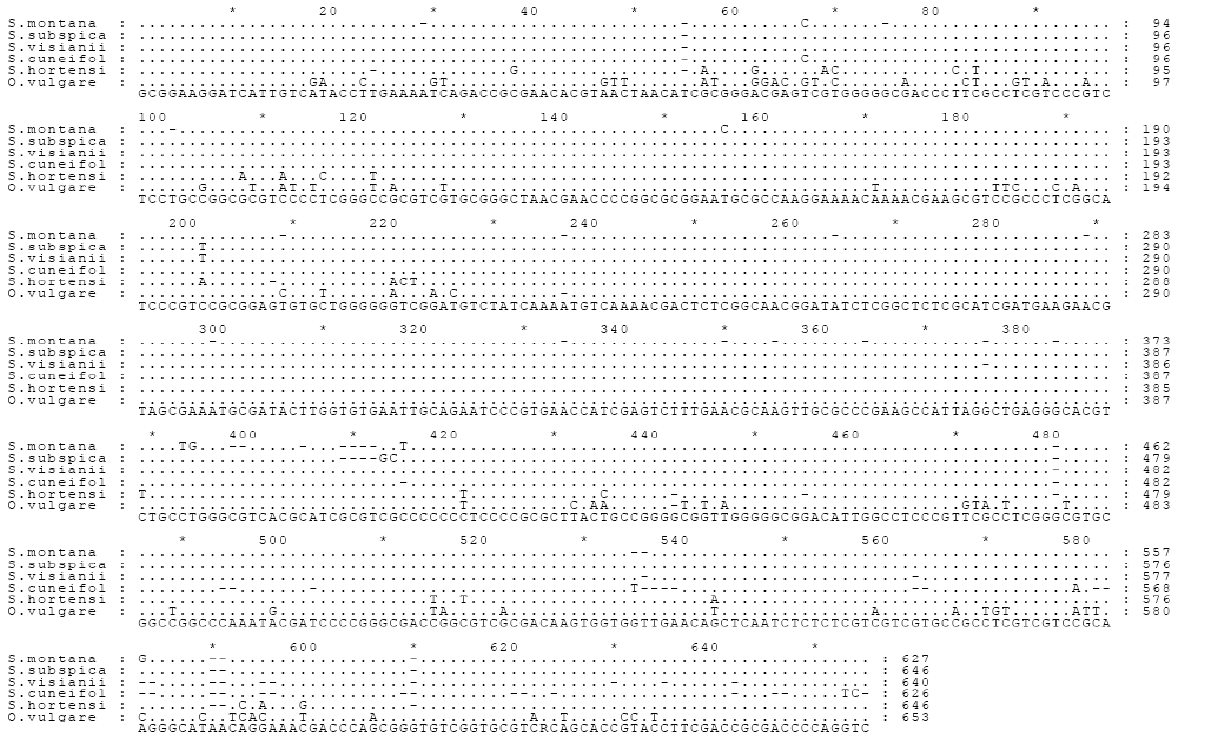
Figure 1. The alignment of ITS consensus sequences of S. montana (EU823287), S. subspicata (EU823288), S. visianii (EU823289), S. cuneifolia (EU823290). Sequences for S. hortensis (AY227143) and O. vulgare (AY506647) have been taken from the